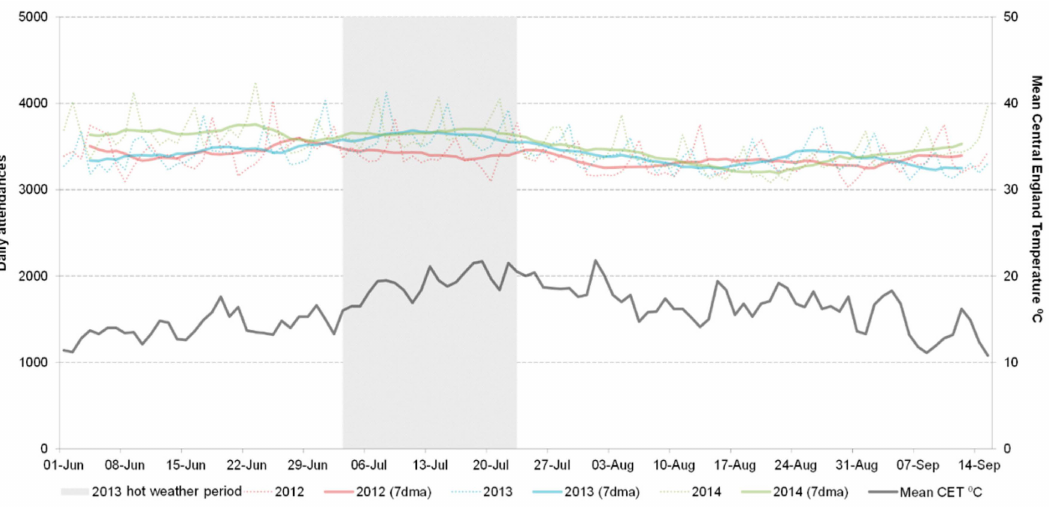
Figure 3. Total daily emergency department attendances reported to the EDSSS (including seven day moving average) 2012–2014 including 18 emergency departments reporting to the EDSSS